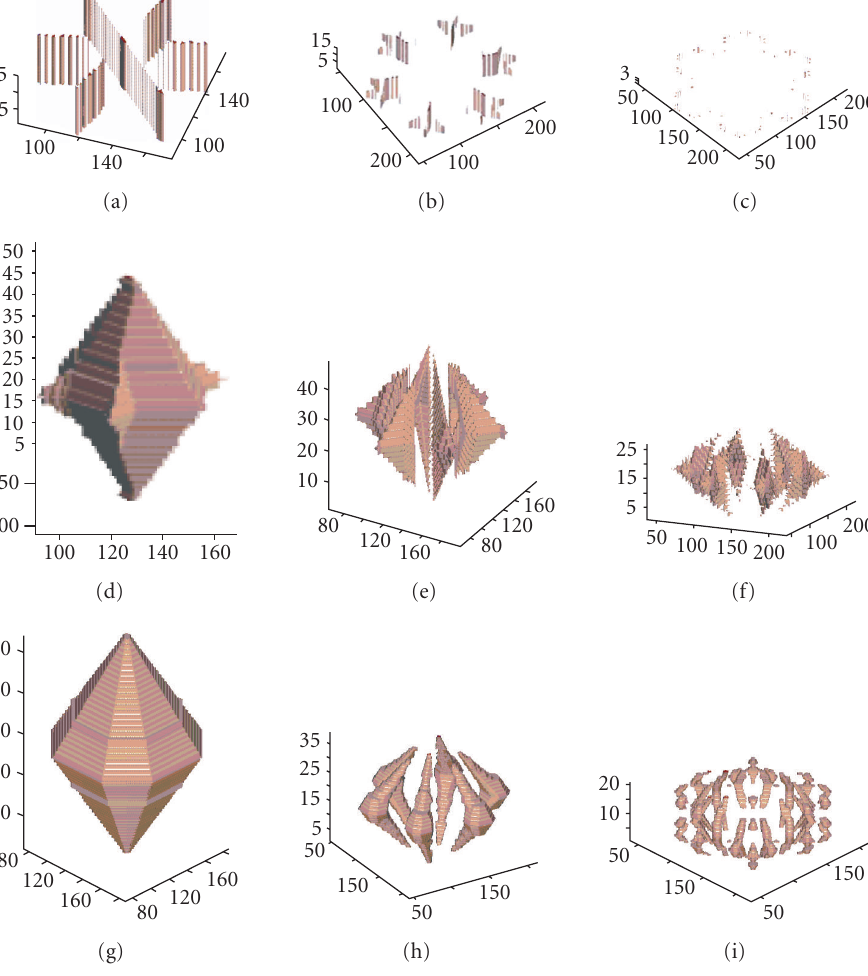
Figure 4.3. Orderwise (a)–(c) pore-channels, (d)–(f) pore-throats, and (g)-(h)